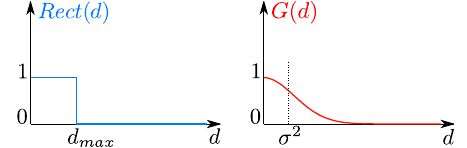
Figure 10: Both Rect ( d ) and G ( d ) can be used to add the scores of each point to the score of a line, depending on their orthogonal distance d to this line. Rect ( d ) is parameterized by the maximal distance for inliers d max and G ( d ) is parameterized with σ